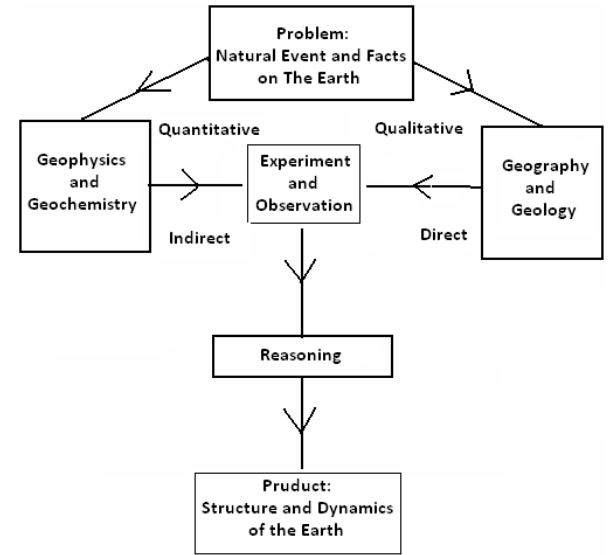
Figure 1. Geophysical approach to solving earth-related problems.